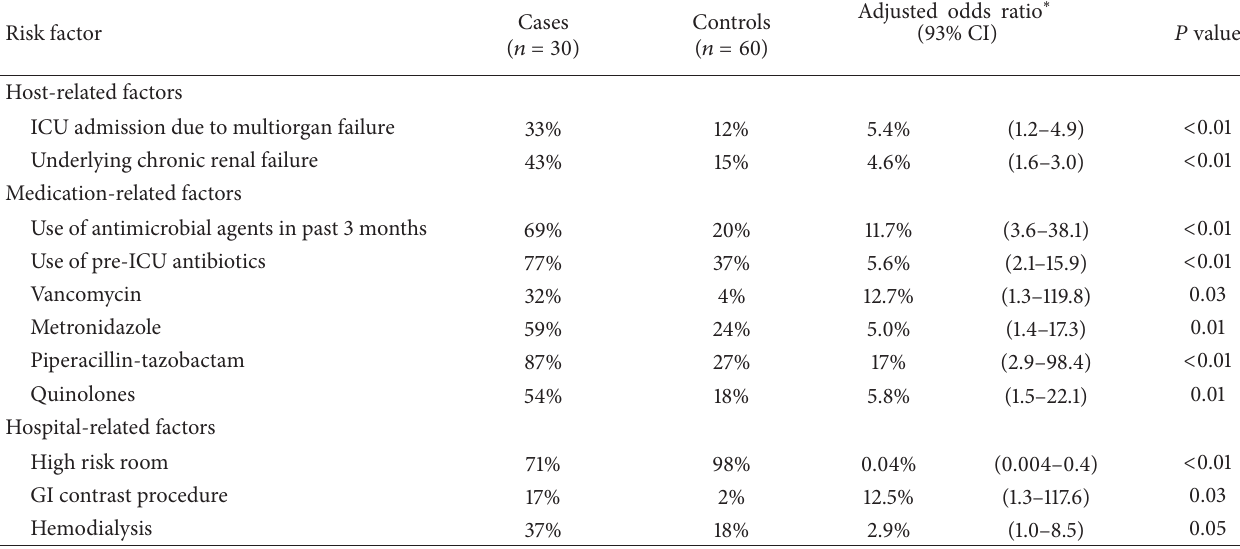
Table 2: The risk factors that were found significantly associated with VRE on univariate